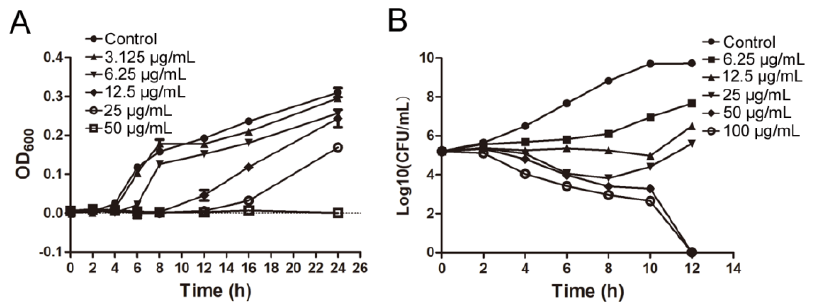
Figure 5. The bacterial growth curve and determination of and bactericidal and bacteriostatic activities of IMB-0042. ( A ) Different concentrations of IMB-0042 (ranging from 3.125 µ g/mL to 50 µ g/mL) were added to the tubes containing the logarithmic phase cells (diluted to 10 5 CFU/mL) and incubated at 37 ◦ C with shaking at 150 rpm/min. Samples were collected every hour to measure optical density at 600 nm (OD 600 ) to plot the growth curve. ( B ) An initial inoculum of approximately 2 × 10 5 CFU/mL of E. coli ATCC 25,922 was incubated in LB medium containing diffrent concentrations of the compound IMB-0042. The cells were incubated at 37 ◦ C with shaking at 150 rpm/min in the presence of IMB-0042 (ranging from 6.25 µ g/mL to 100 µ g/mL), and the colony numbers were counted over time.